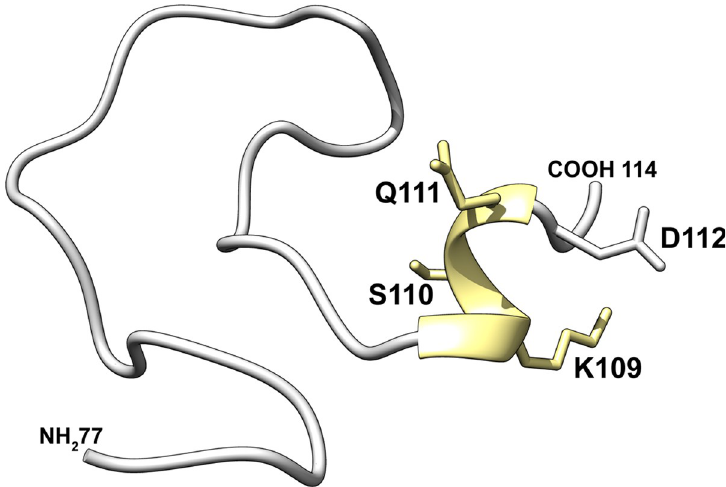
Fig 9. Homology model of the VZV gB N-terminus. Residues 77–114 of VZV gB were subject to homology modelling using RaptorX [88]. The predicted α -helix is colored yellow.